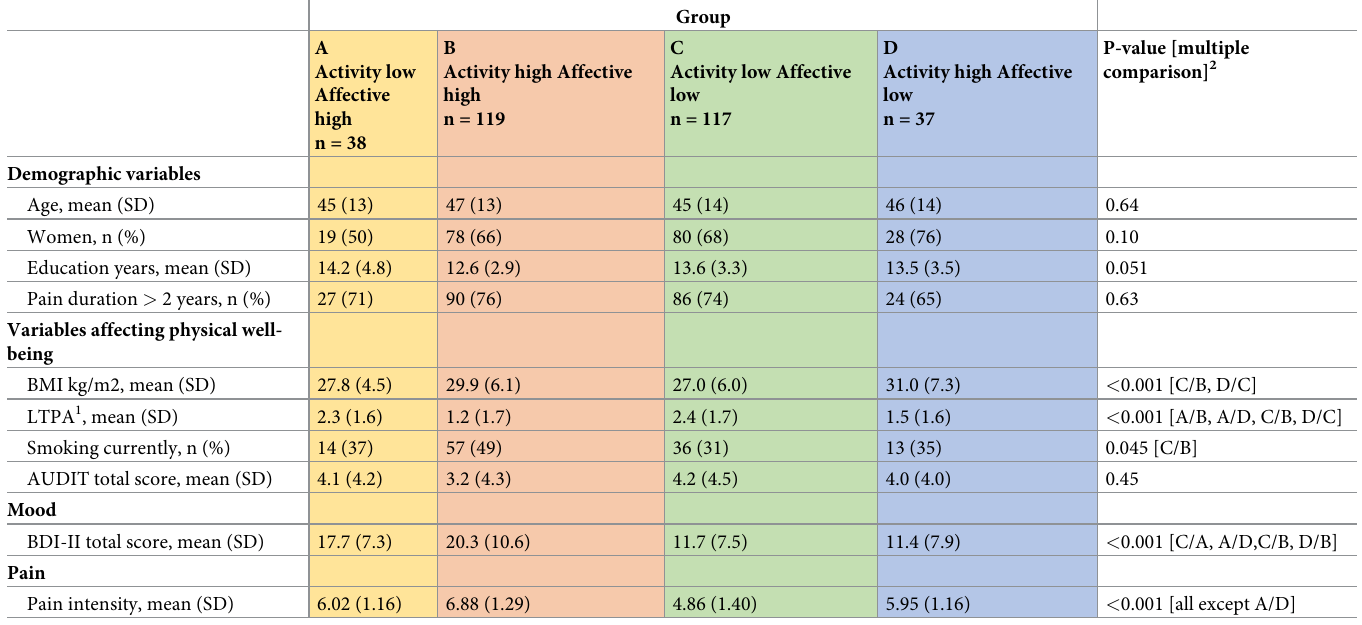
Table 1. Demographic variables and variables affecting physical well-being, mood, and